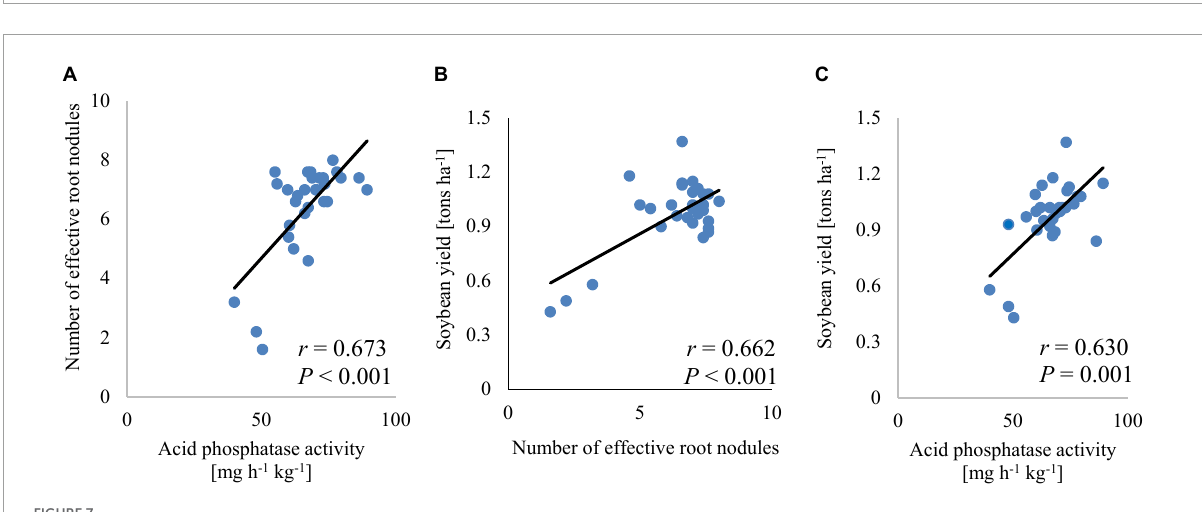
control and sole AMF treatments highlights the potential